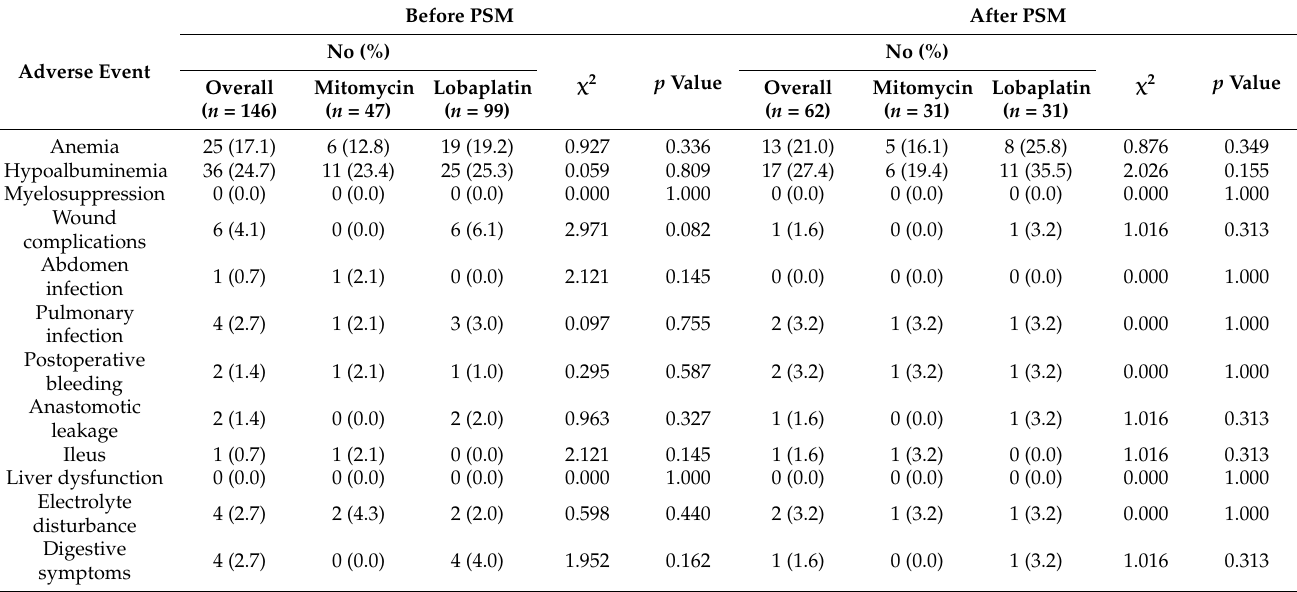
Table 3. Adverse events of patients with advanced colorectal cancer before and after